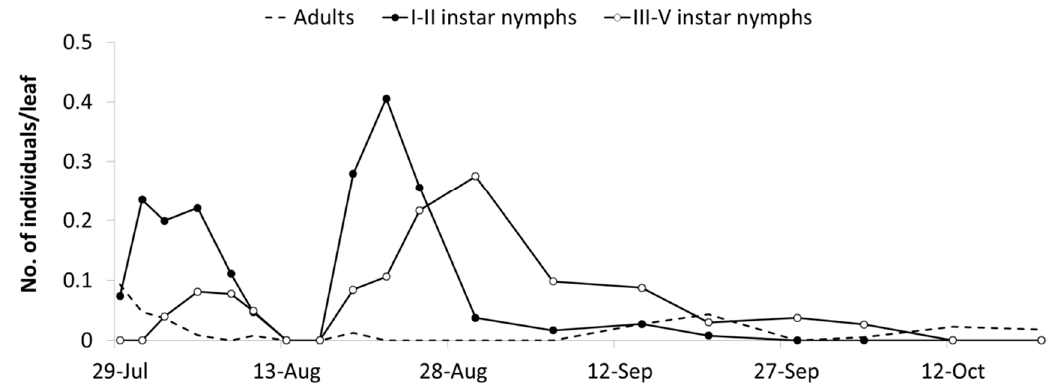
Figure 3. Seasonal abundance of Erasmoneura vulnerata nymphs and adults observed on leaves of potted vines placed close to rural buildings (A1 area, 2008).